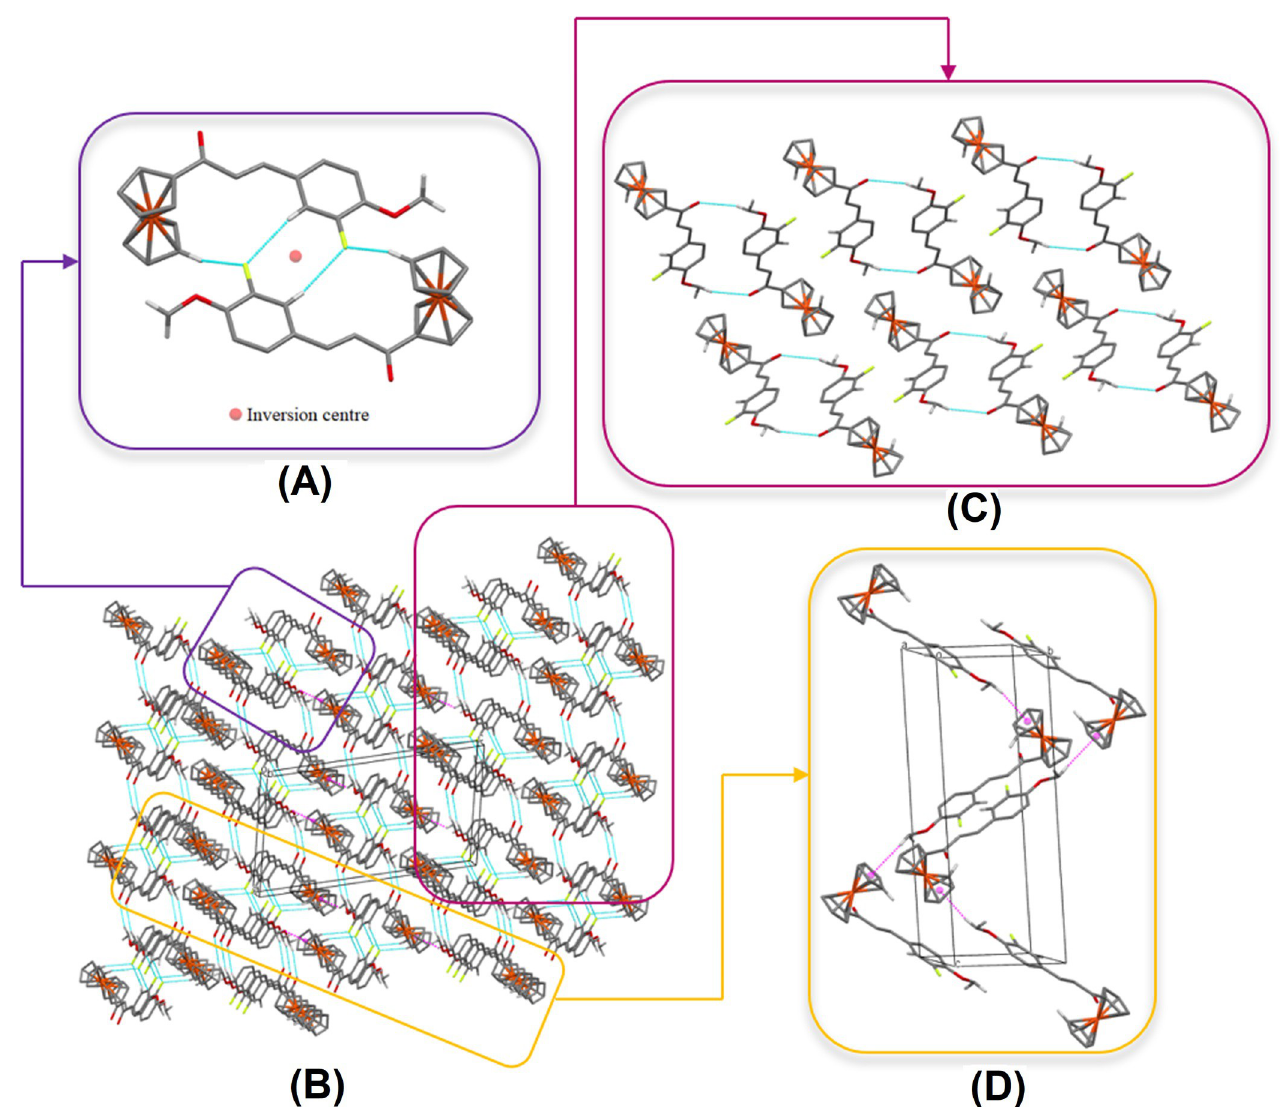
Fig 6. Crystal packing of Fc2. (A) A view of a centrosymmetric dimer with weak intermolecular C19—H19 A ��� F1 and C4—H4 A ��� F1 interactions shown as blue dotted lines (B) A full view of crystal packing within a unit cell (C) A partial parts of C20—H20 C ��� O1 interactions (D) The head-to-tail arrangement of C20—H20 A ��� Cg